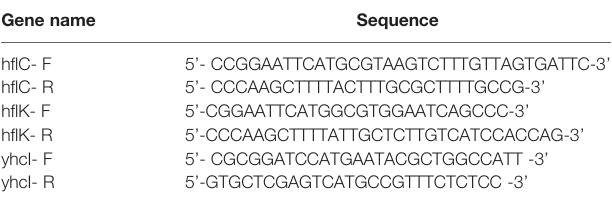
TABLE 1 | List of primers used for ampli fi cation of h fl C, h fl K, and yhcI